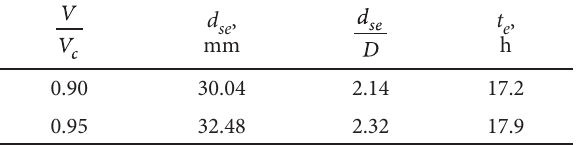
Table 2. Comparison of non-dimensional depth of scour between researchers